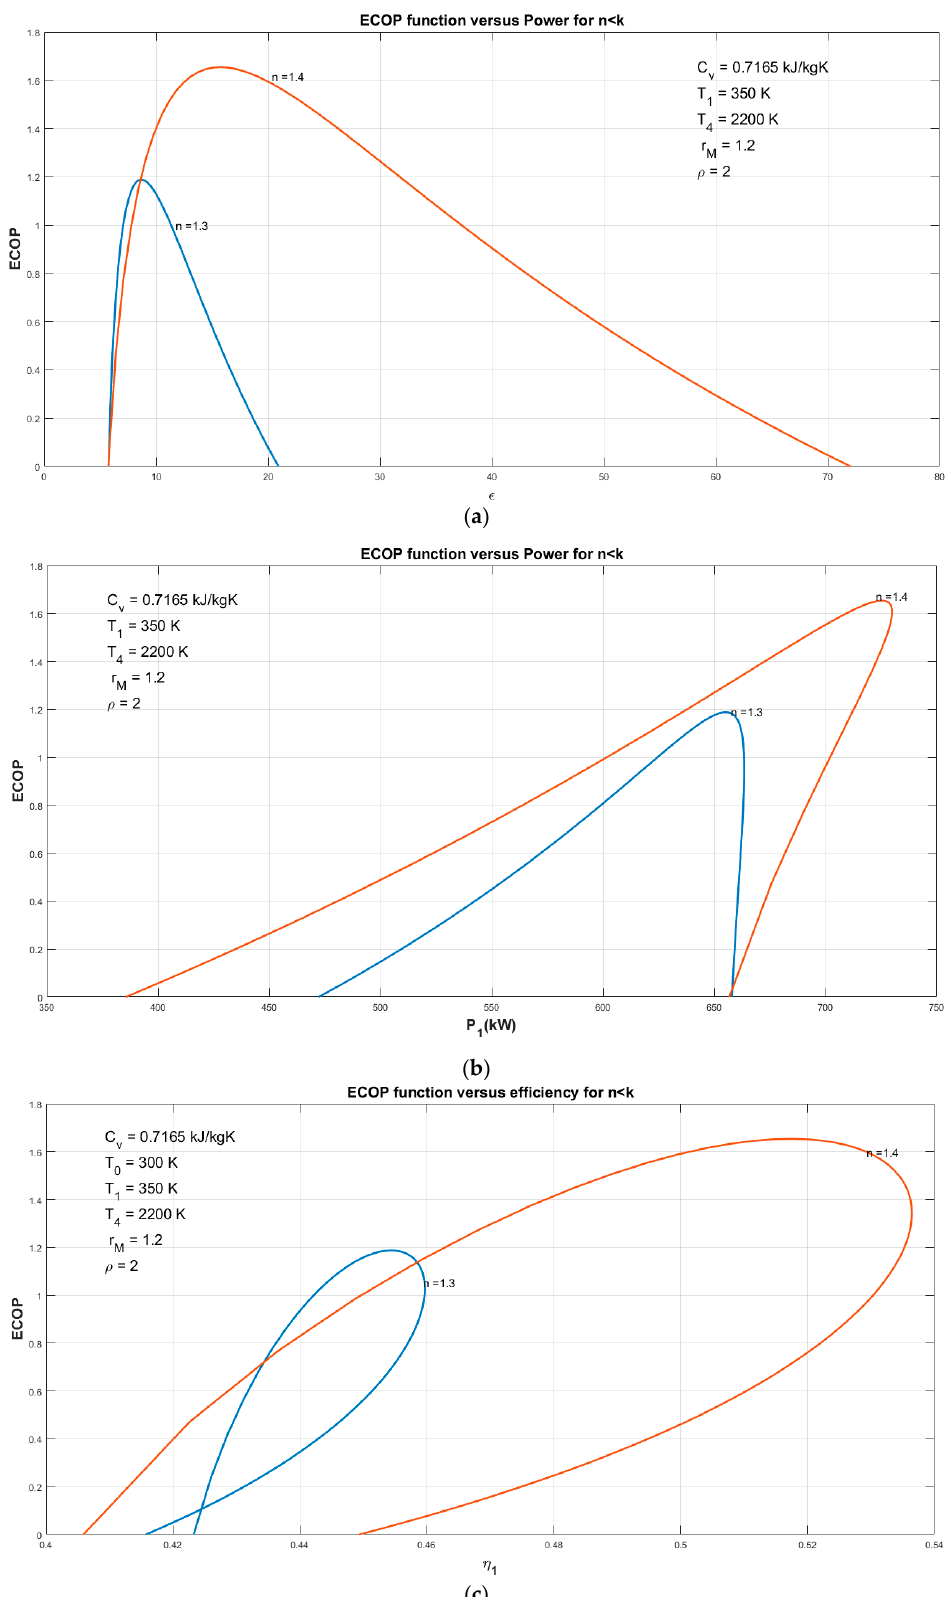
Figure 5. Impact of n ( n < k ) on ecological coe ffi cient of performance (ECOP)– ε ( a ), ECOP– P 1 ( b ) and ECOP– η 1 ( c